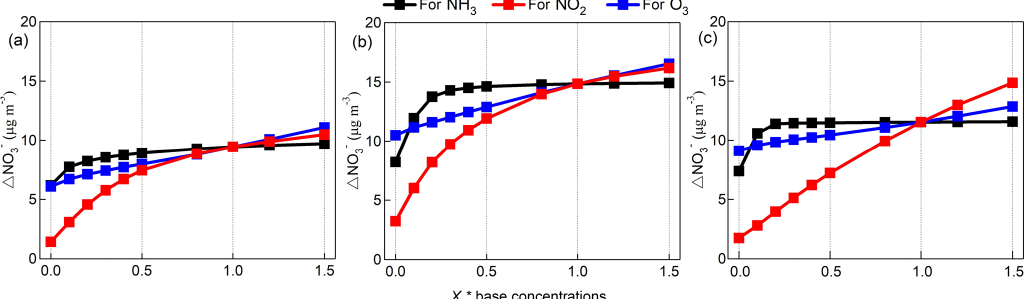
enhancements as a function of the X times of the base concentrations of NH 3 , NO 2 and 3